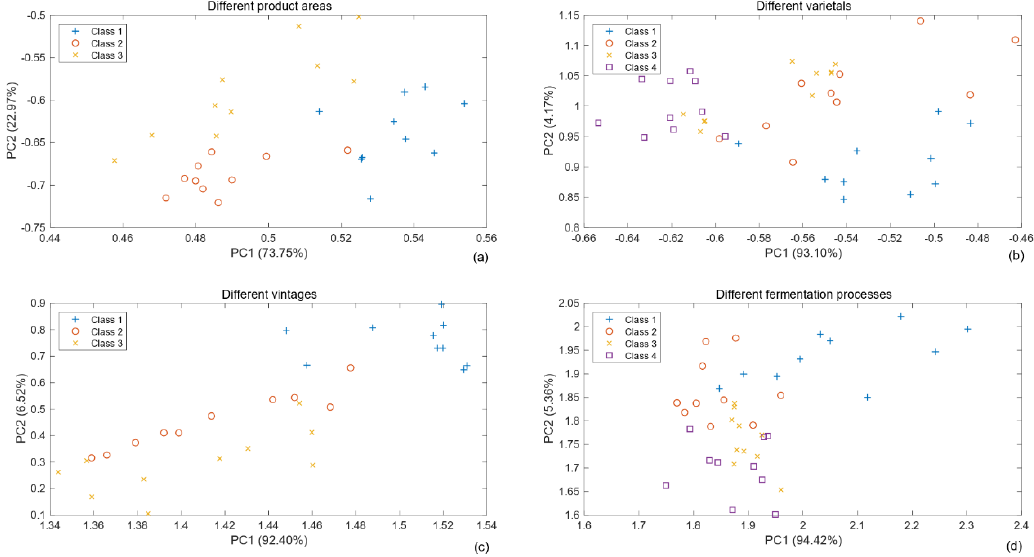
Figure 5. Principal component analysis (PCA) plots of different wine samples measurements (each kind of sample from the training lots were presented). ( a ) the samples with different product areas; ( b ) the samples with different varietals; ( c ) the samples with different vintages; ( d ) the samples with different fermentation